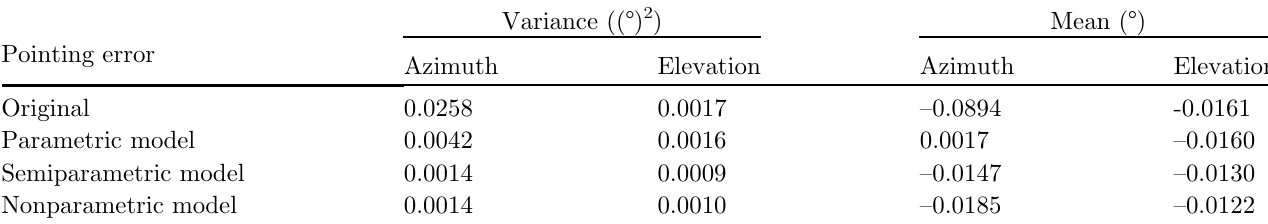
Table 2. Prediction results comparison among different models for test